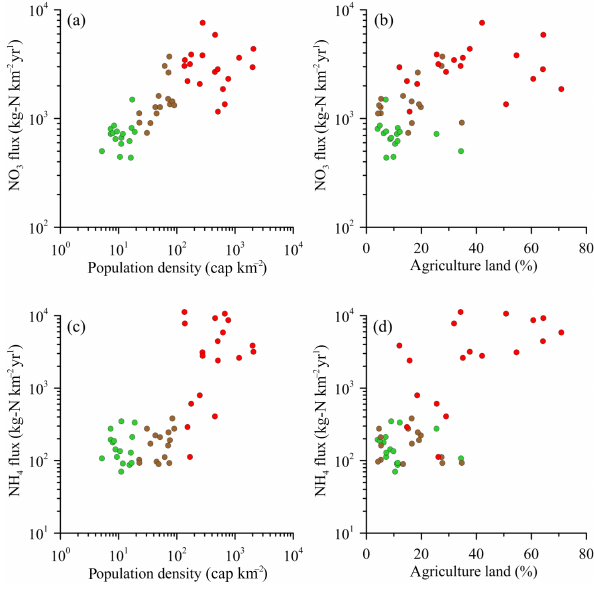
Figure 4. Scatterplot of NO 3 and NH 4 export associated with pop- ulation density, (a) and (b) , and relative agricultural land cover, (c) and (d) . The green, brown, and red dots show the low, moderately, and highly disturbed watersheds, respectively. The r -squared values for (a) , (b) , (c) , and (d) are 0.19, 0.34, 0.18, and 0.50, with p values <0.01,